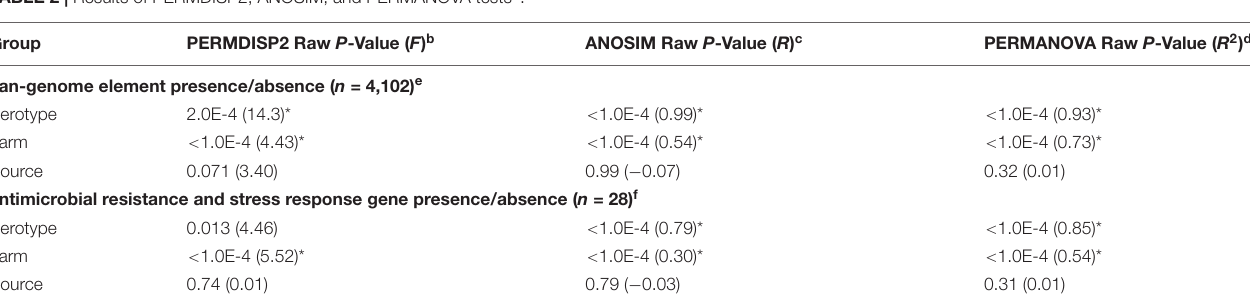
TABLE 2 | Results of PERMDISP2, ANOSIM, and PERMANOVA tests a